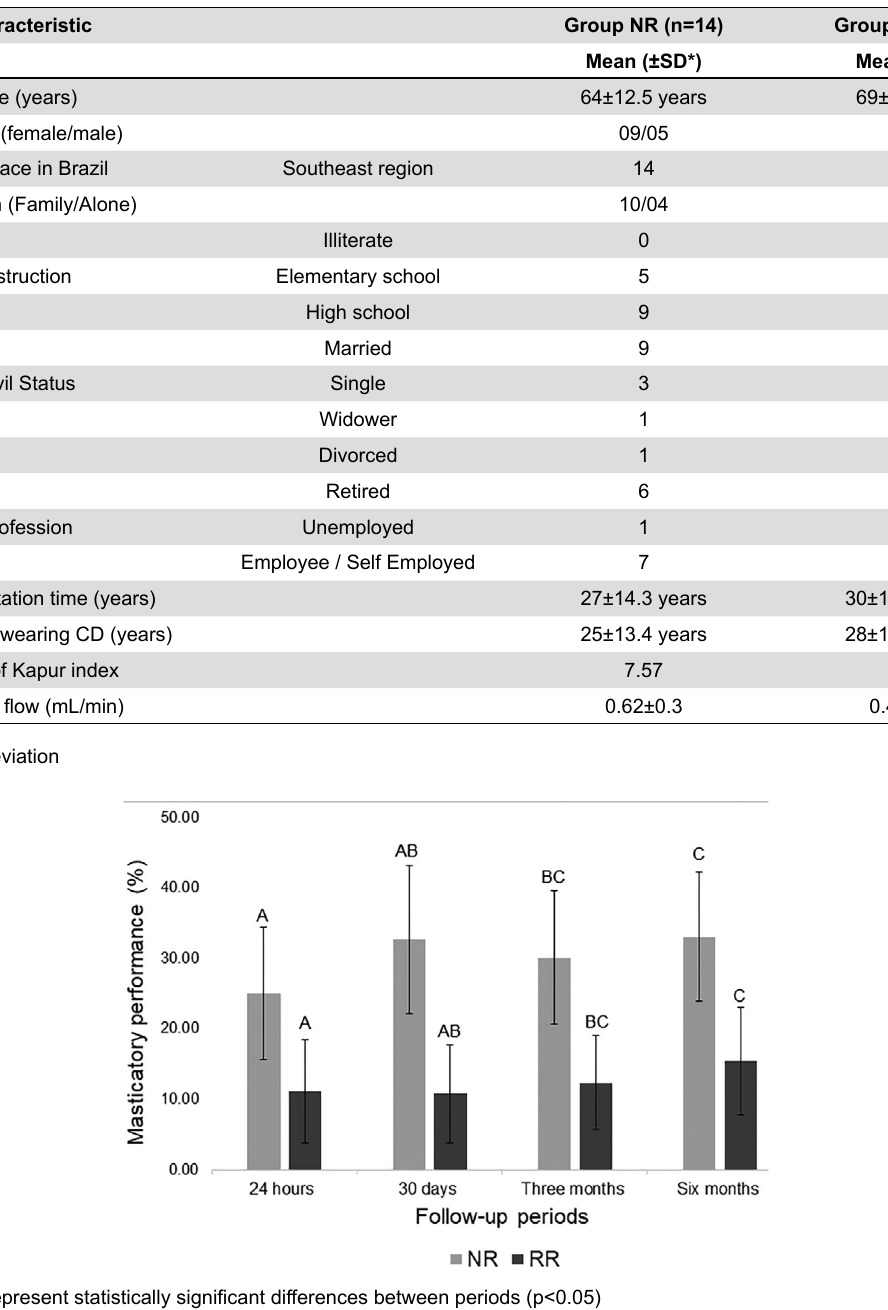
Different letters represent statistically significant differences between periods (p<0.05) Figure 2- Multiple comparisons of masticatory performance (Bonferroni’s test,